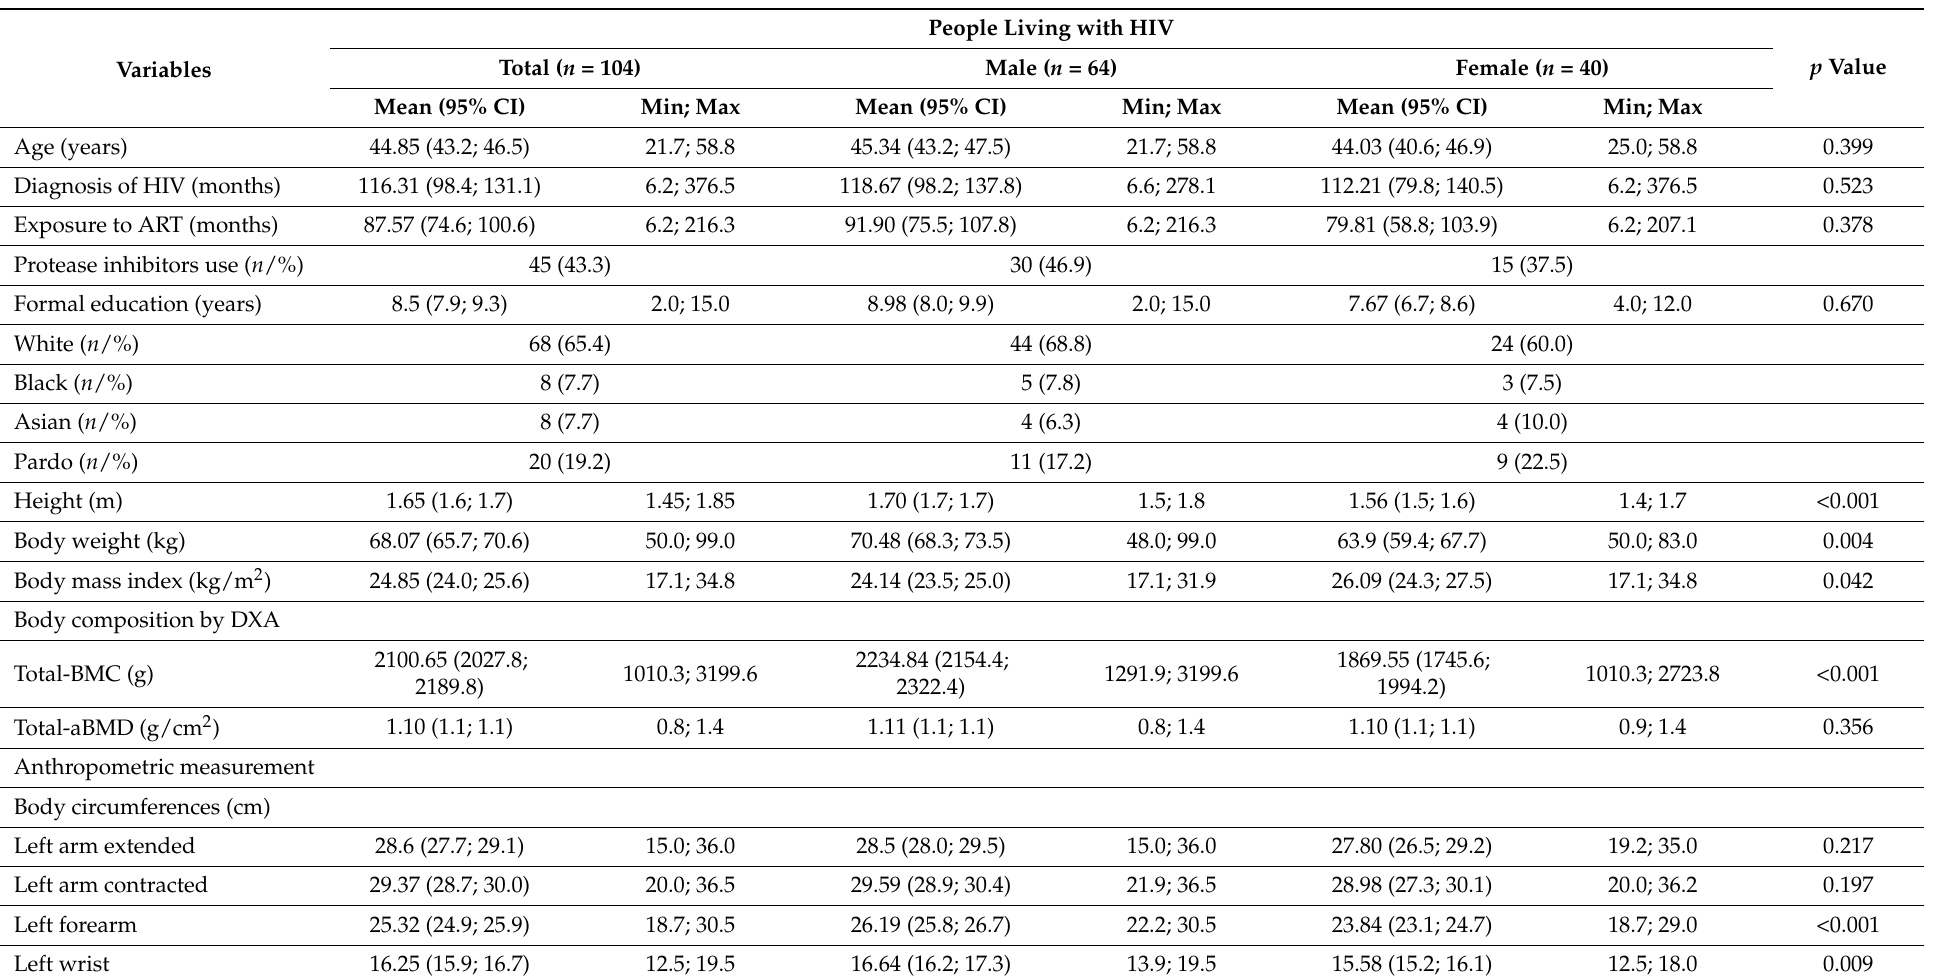
Table 1. General sociodemographic, anthropometric, and body composition characteristics of the sample overall and separated by